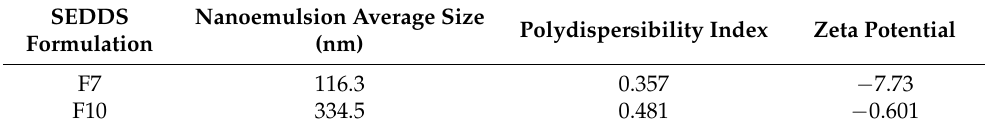
Table 2. Characterization of nanoemulsions.